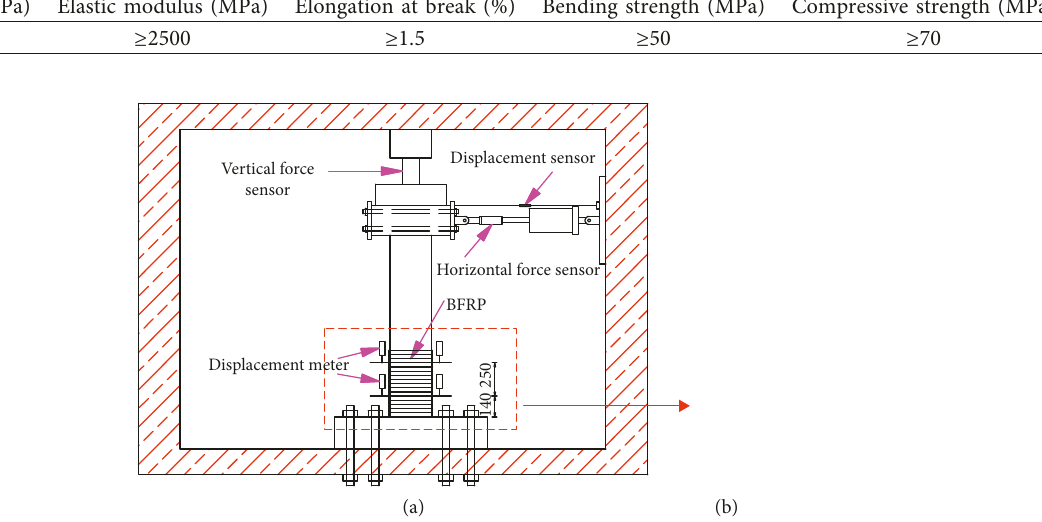
Figure 3: Measuring points arrangement: (a) deformation measuring points; (b) strain measuring points (unit: